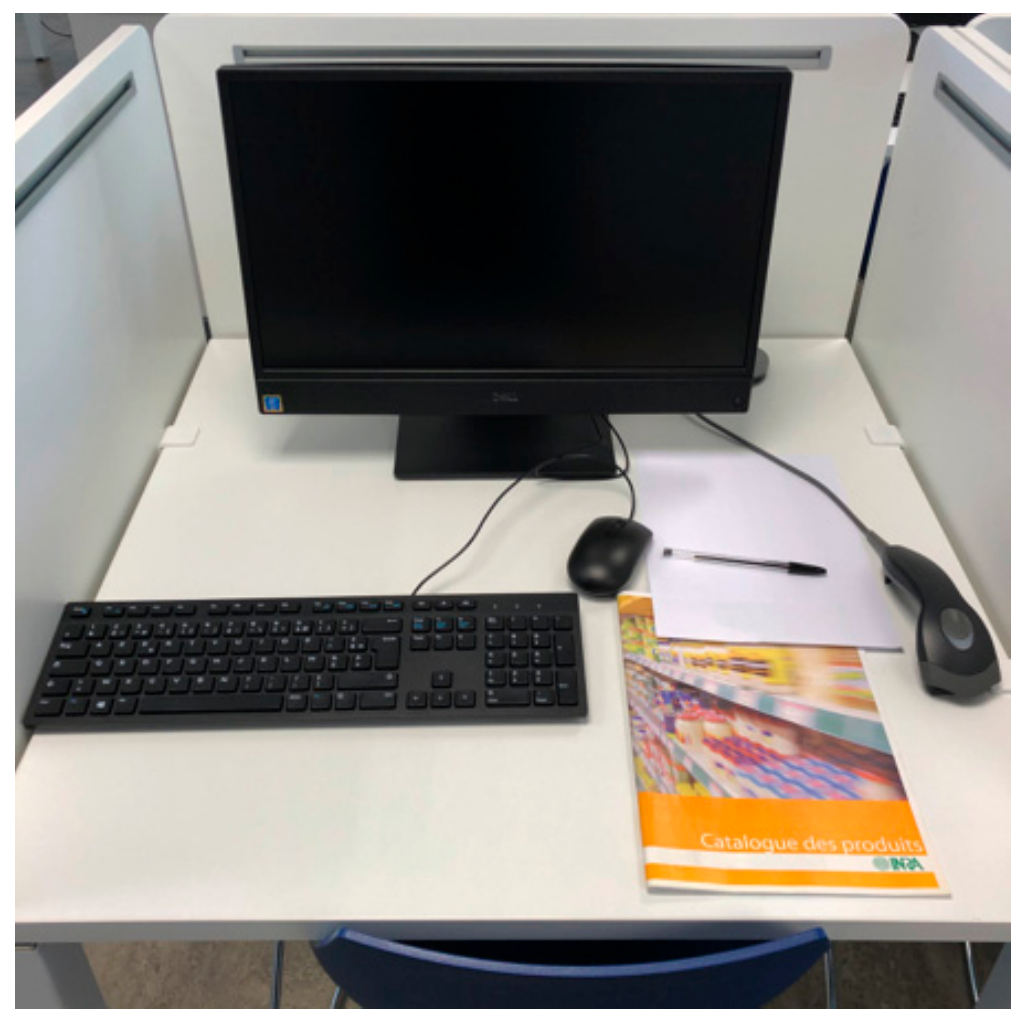
Figure A14. Subjects’ decision booth with computer, food catalogue, barcode reader and pen and paper.